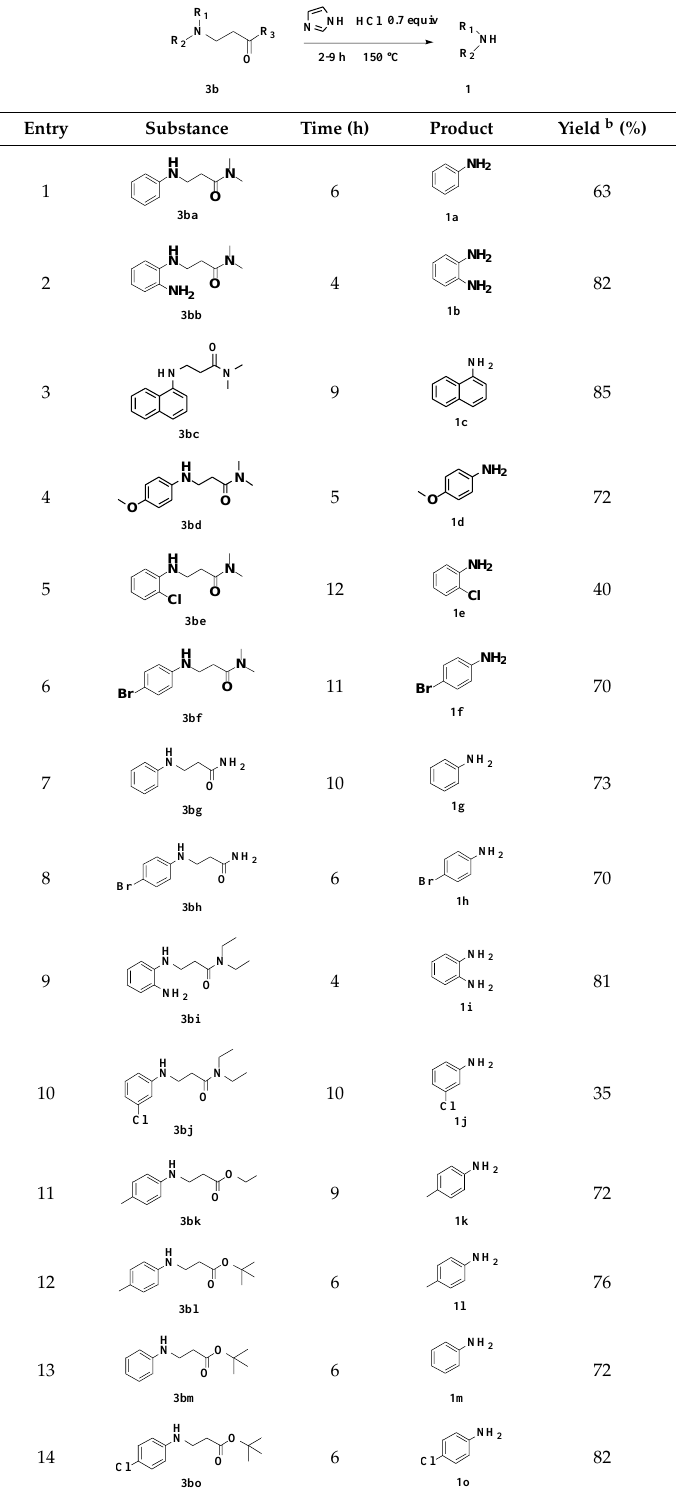
Table 5. Substrate scope of the deprotection of aromatic amino groups. a